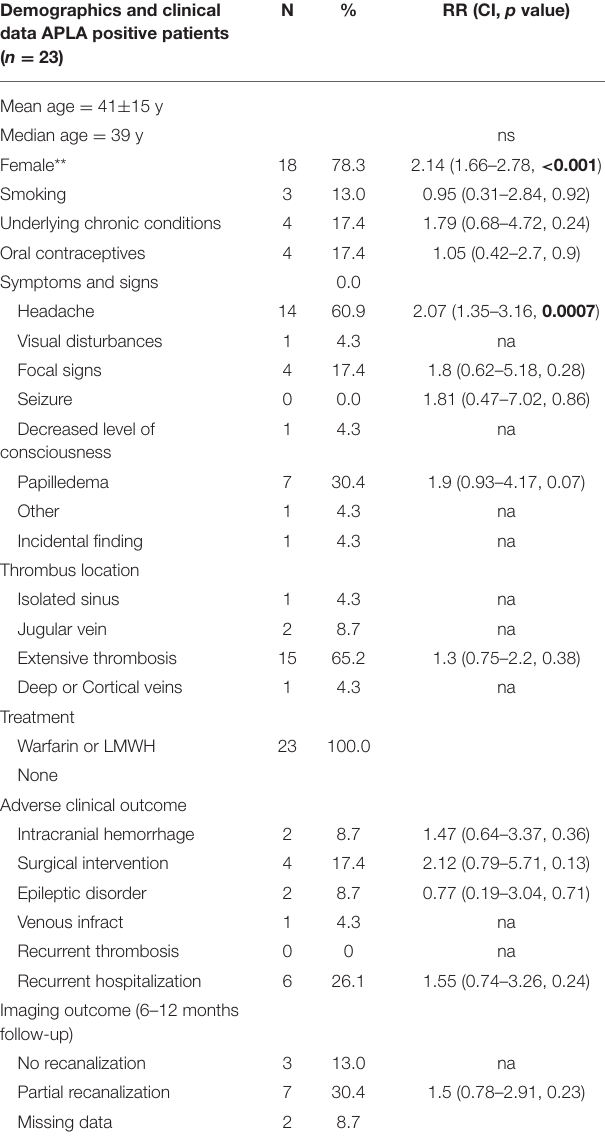
common thrombosis locus involved a superficial venous system, with a minority of the cases presenting with deep/cortical or cervical venous